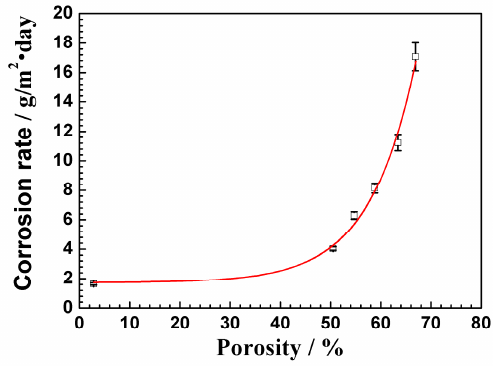
Figure 9. Influence of porosity on corrosion rate of Ti-10Mo alloy.